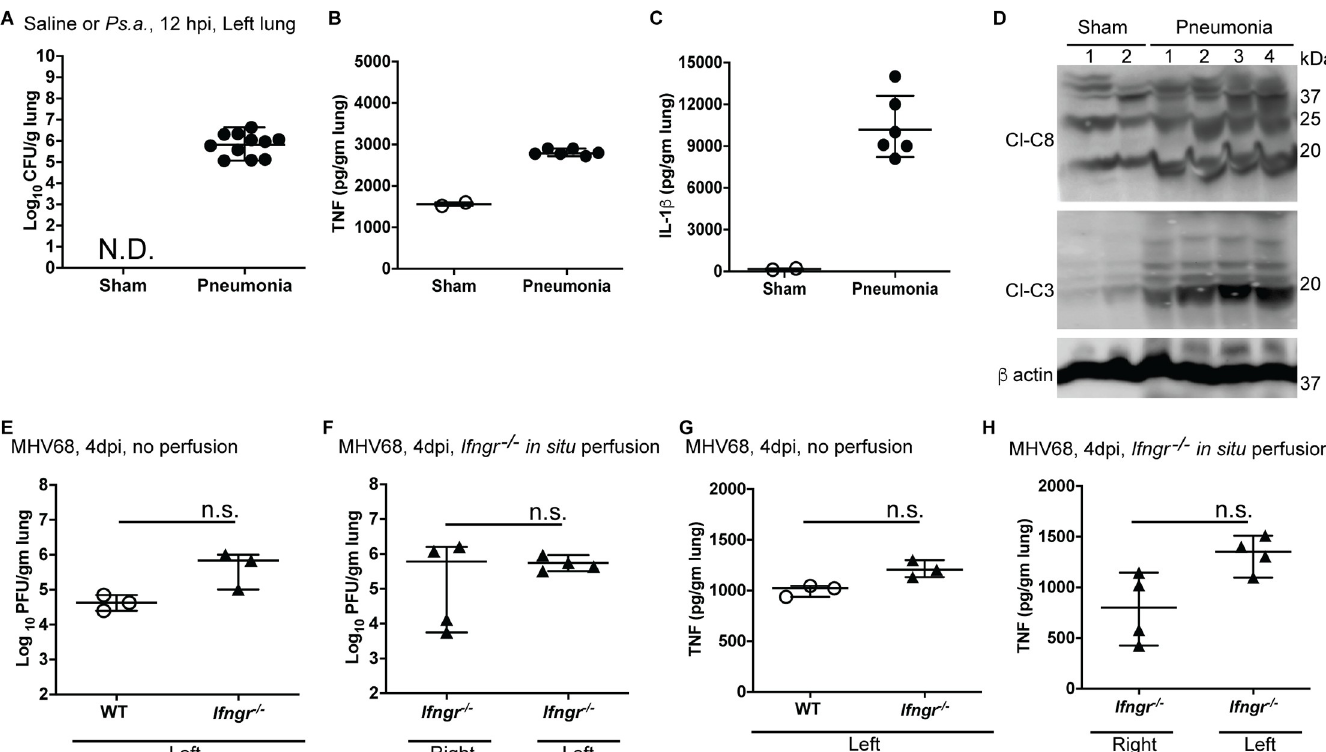
Fig 3. Biological data from one mouse. (A, B) Sham-treated or Pseudomonas -infected mice at 12 hours post infection (hpi; mice undergoing pneumonia) or treatment where each mouse was inoculated with 40 ul of 2X10 8 CFU/ml Pseudomonas aeruginosa (ATCC 27853; approximately 8X10 6 CFU per mouse) were used to quantify bacterial load ( A , n = 2 and 11 mice for sham and infected groups respectively) on blood-agar plates and cytokines IL-1 β (B) , as well as TNF by ELISA ( C; n = 2 and 6 mice for sham and infected groups respectively) by ELISA. N.D. is not detected. (D ) Immunoblot of lung lysates from sham treated (n = 2) or septic (n = 4) WT mice indicating appearance of cleaved CASP8 (Cl-C8; 18 kDa) and Cl-CASP3 (Cl-C3; 19, 17 kDa) with loading control β -actin. (E-F) MHV68 titer in lungs from infected WT and Ifngr -/- mice without perfusion (E) or infected Ifngr -/- mice with in situ perfusion (F) 4 days-post-infection (dpi) where each mouse was inoculated with 5X10 5 PFU of virus in 20 μ l complete medium. (G, H) TNF levels detected by ELISA in lung sections from same mice depicted in (E) and (F) respectively. Each data point represents one mouse with 3–4 mice per group per condition. For each experiment all groups included comparable numbers of age-matched male and female mice. Error bars show mean error and range. Statistical analyses between groups were performed using unpaired t-test with Welch’s correction. n.s. is non-significant. solvent for titer, cytokine analysis or immunoblot. To evaluate bacterial titer (Fig 3A), soni- cated lung lysates were serially diluted in PBS before spreading on pre-warmed (37˚C) blood agar plates. Plates were incubated at 37˚C for 18–24 h before assessment of bacterial colonies. Plates exhibiting between 10–100 colonies were considered. Counted colonies were expressed as bacterial load after adjustment for tissue weight and dilution (Fig 3A). All infected mice exhibited comparable bacterial titer in the left lung. We did not detect bacteria in sham-treated mice confirming sterile technique was maintained during harvest without cross-contamina- tion. For determination of MHV68 titer, sonicated lysates were serially diluted in medium and plated on murine fibroblast monolayers (Fig 3E and 3F). Seven days later, plates were stained and wells with 20–200 viral plaques were counted and adjusted for tissue weight before calcu- lating titers. At 4 dpi, WT and mutant mice had comparable viral titer in the left lung, assayed without perfusion (Fig 3E). To determine whether in situ fixation impacts viral titers, we assessed titers in lungs from cadavers where our perfusion method was applied (Fig 3F). Left lungs from perfused Ifngr -/- mice exhibited similar titers (~10 6 PFU/gm tissue) when com- pared to left lungs from the unmanipulated mice (Fig 3E and 3F). Perfused right lungs showed a range of viral titer (~10 3 − 10 6 PFU/ml) suggesting that formalin perfusion for 20 mins